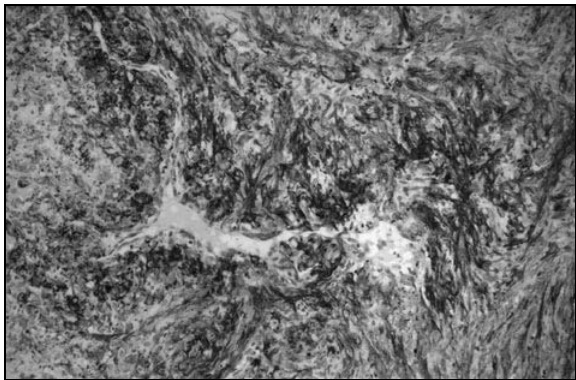
Figura 3 – Expressão da actina de músculo liso pelas células musculares neoplásicas. Ausência de marcação nas células endoteliais. (imuno-histoquímica, estreptavidina- biotina-peroxidase – aumento original 200 vezes)